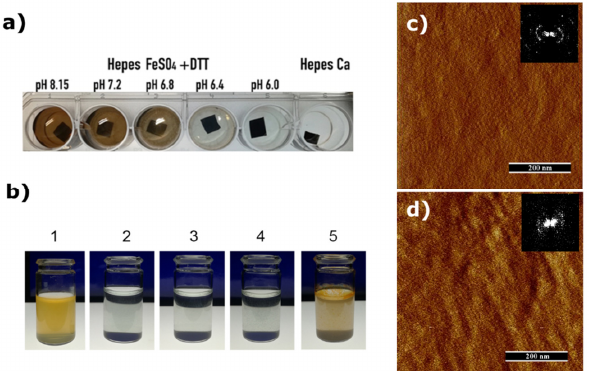
Figure 1. ( a ) S-layer recrystallization on hydrophobic silicon wafers in the presence of a 2 mM FeSO 4 ·7·H 2 O solution in degassed 0.1M HEPES buffer (+5mM DTT) at different pH values. ( b ) Time course (images 2–5) of Fe² + auto-oxidation (2 mM FeSO 4 ·7·H 2 O/5 mM DTT in 0.1 M HEPES at pH 6.3). Pictures were taken after 30 min (2), 180 min (3), 420 min (4) and overnight (5). Sample 1 acts as positive control in the absence of DTT and without previous degassing (image taken after 30 min). (Right) AFM topography micrographs of SbpA recrystallized onto silicon wafers under degassed solutions of either FeSO 4 ( c ) or FeCl 2 ( d ). The crystalline character of the S-layer patches could further be confirmed through Fourier domain analysis (insets). The multiple first order spots reflect the highly disordered paving of the small crystalline domains. Their reciprocal spacing of ca. 13 nm corresponds to the lattice constant of the SbpA S-layer lattice with its square lattice symmetry. Scale bars = 200 nm.